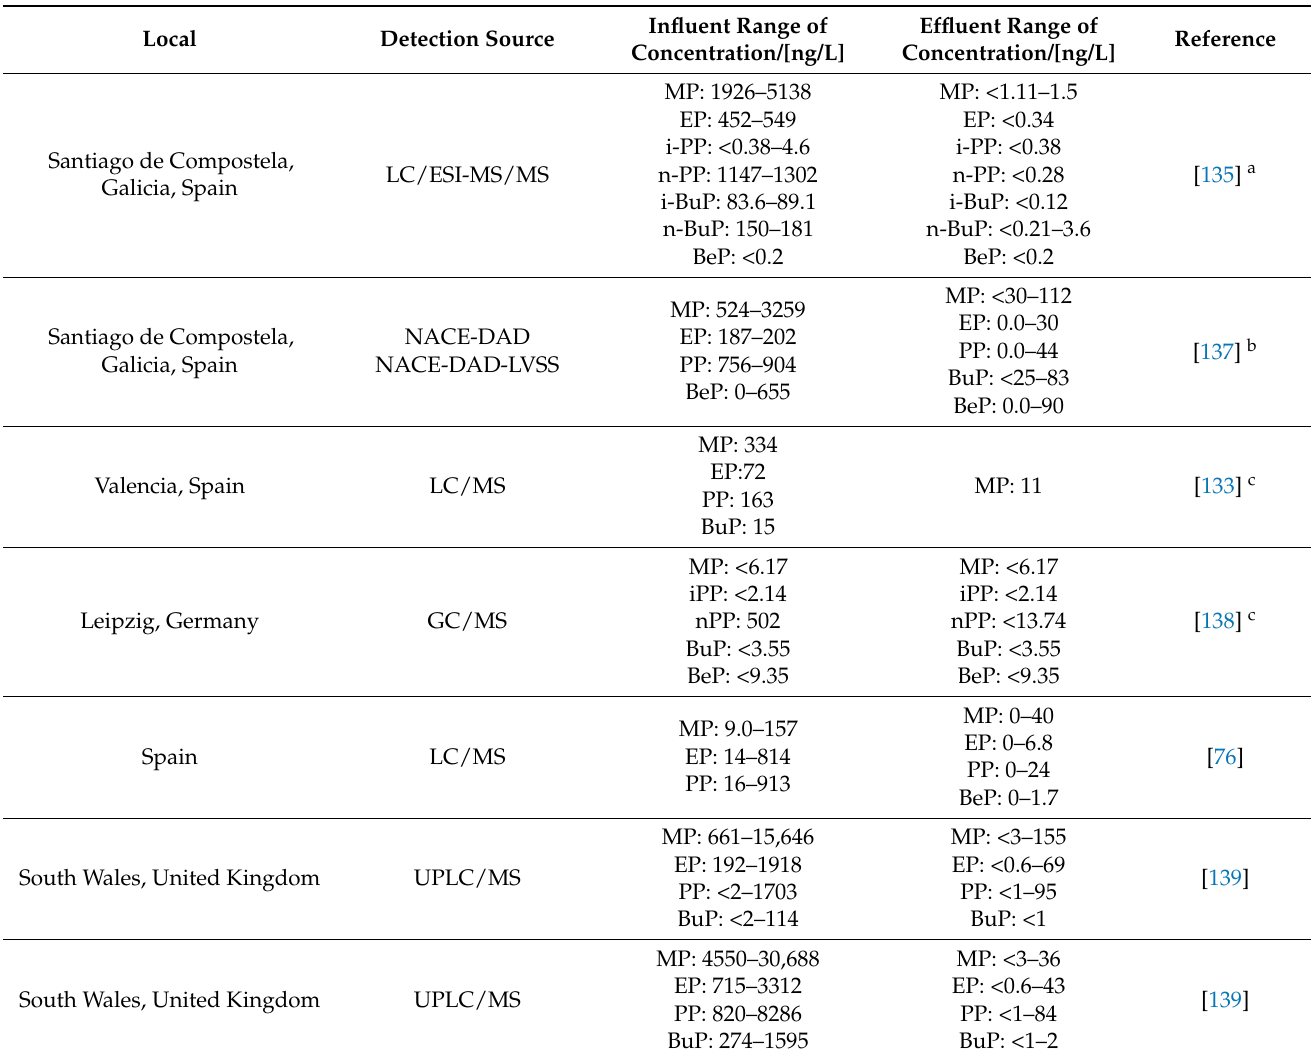
Table 4. Paraben detection in wastewater treatment plants